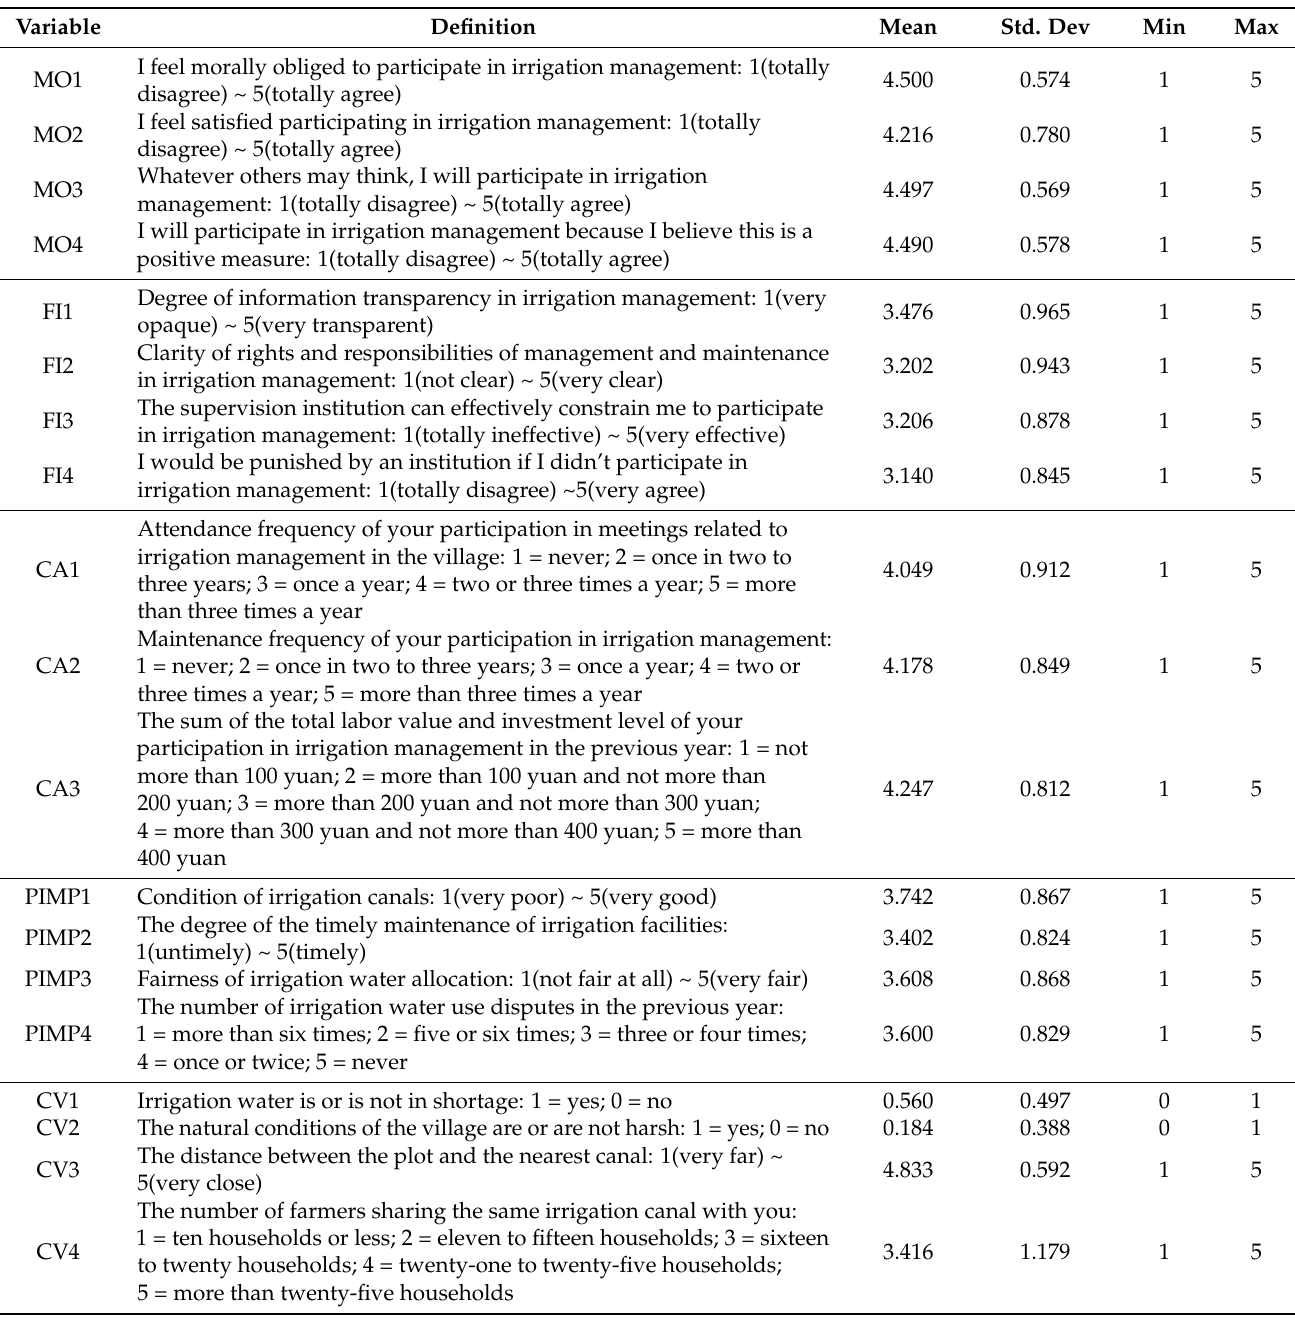
Table 1. Definitions and summary statistics of